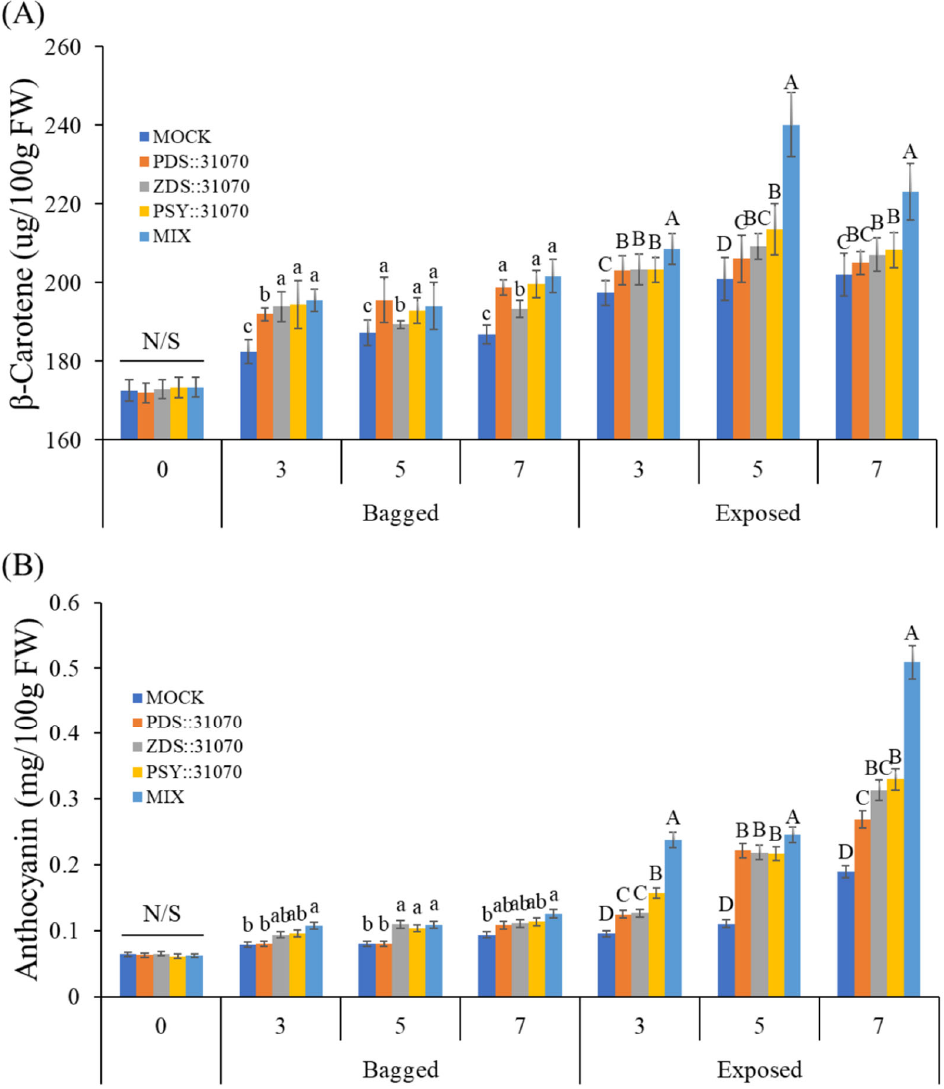
Figure 8. Accumulation of β -carotene ( A ) and anthocyanin ( B ) in the skin of the apple ‘RubyS’ under different treatment (light and overexpression of carotenoid biosynthesis-related genes) conditions. Different lowercase and uppercase letters represent a significant difference ( p < 0.05) in the bagged and exposed fruit. N/S refers to there being no significant difference ( p < 0.05) among groups. Data are presented as mean ± SD ( n = 12) of three biological replicates.